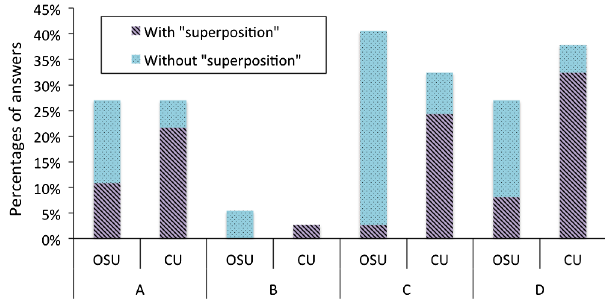
FIG. 8. Frequency of use of the term “ superposition ” in the students ’ answers at OSU versus CU (purple hatched pattern, ¼ 37 , N ¼ 37 ). Explanation of categories A, B, C, and N OSU CU D is presented in Table II.